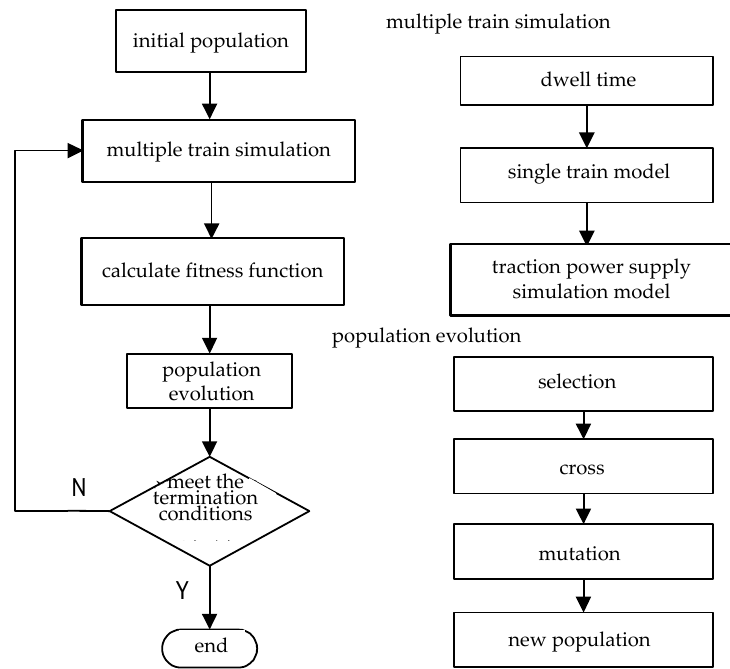
Figure 13. Flowchart of the dwell time optimization algorithm.